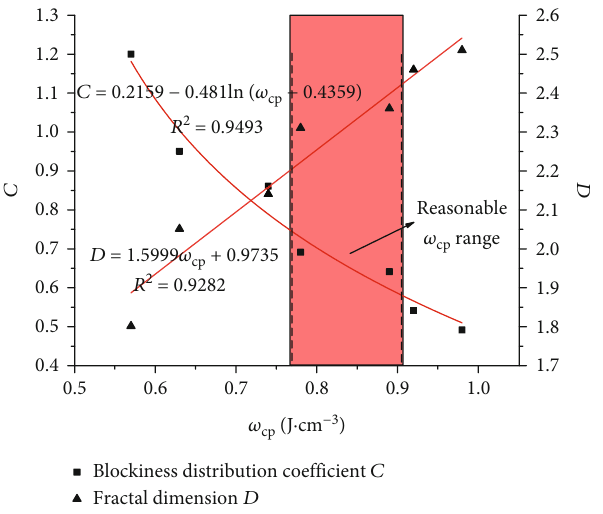
Figure 11: Relationship diagram for determining the range of reasonable crushing energy consumption